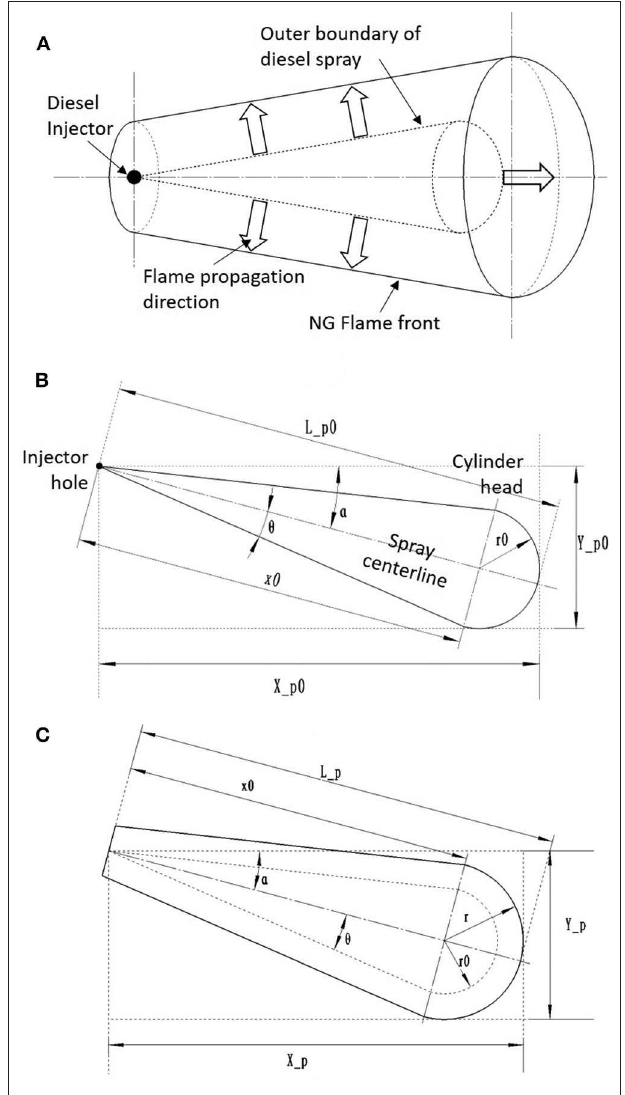
FIGURE 4 | (A) Spatial illustration of NG flame initiation and propagation relative to a diesel spray. (B) Geometrical definitions of a diesel spray at SOC. (C) Geometrical definitions of a free-evolving NG flame